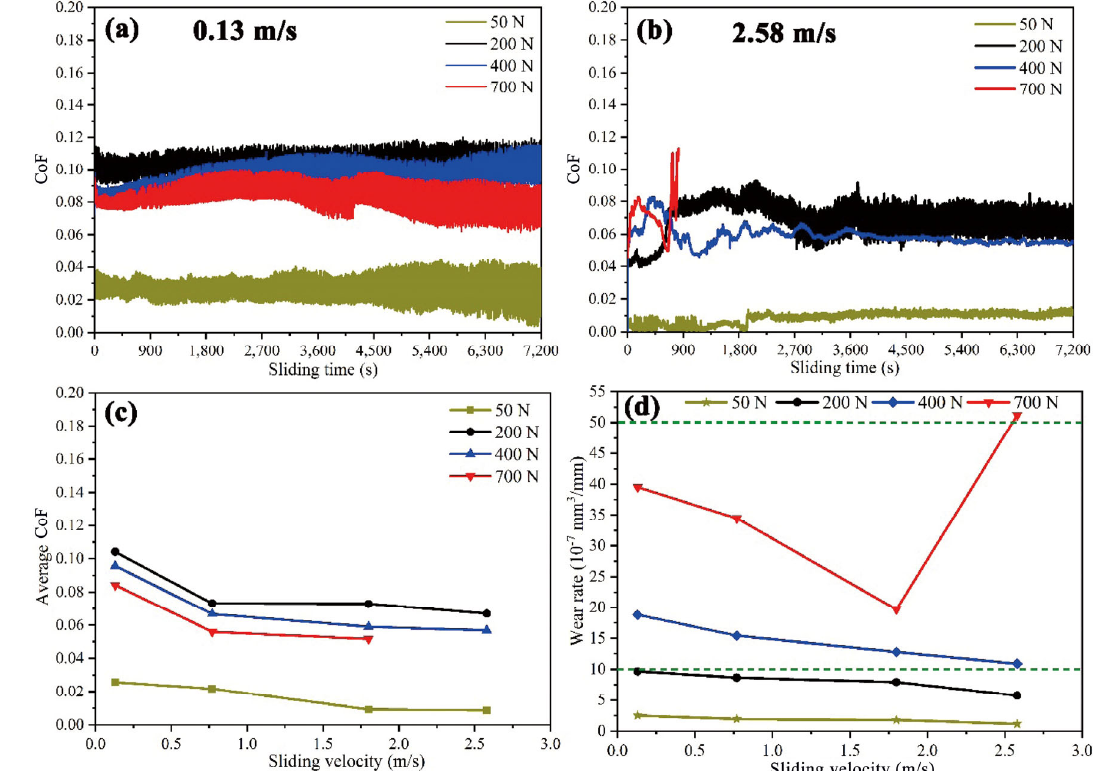
Fig. 7 (a, b) CoF curves, (c) average CoFs, and (d) wear rates of Cu–15Ni–8Sn–0.8Nb alloy sliding against 300M steel under a grease-lubricated condition at different normal loads and sliding